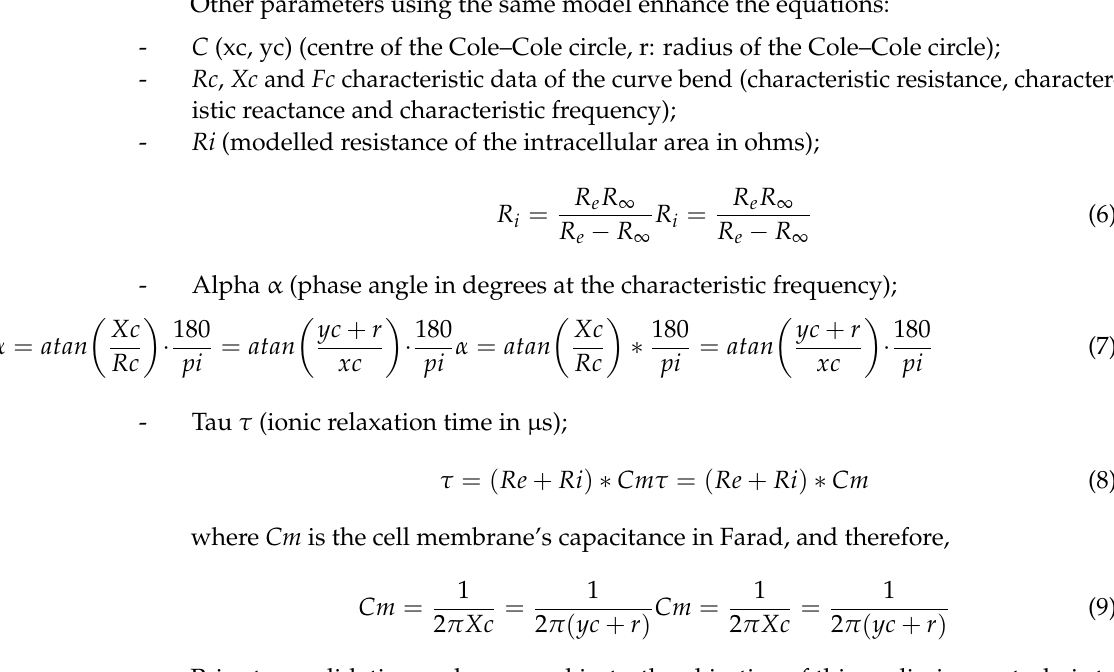
Figure 3. Cole-Cole curve on raw data in the impedance complex plan ( ω = 2 π f in rad.s). Other parameters using the same model enhance the equations: